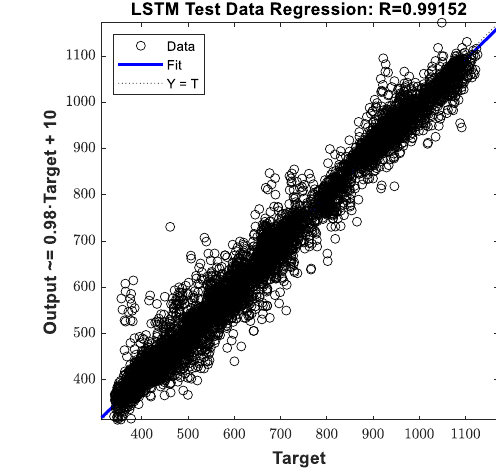
Figure 13. Regression plots for the testing phase.